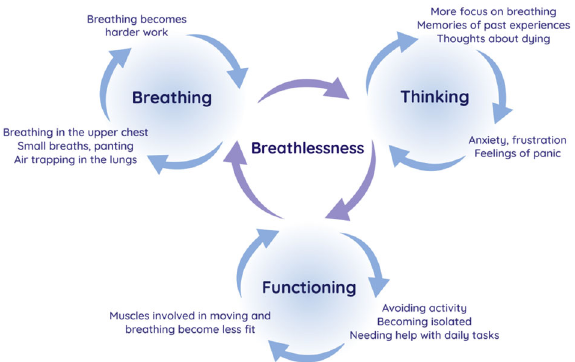
Fig. 1 Breathing, Thinking, Functioning clinical model. The model conceptualises vicious cycles of instinctive emotional and beha- vioural responses to